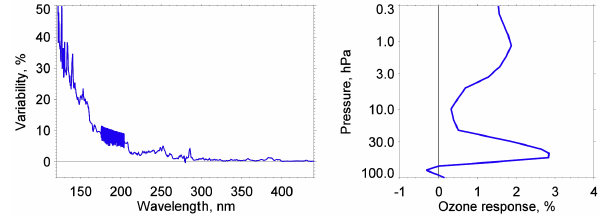
Figure 1. Variability of solar irradiance in the 120–440nm wave- length range calculated by COSI (left) and resulting ozone re- sponse from a composite of observational data from Soukharev and Hood (2006) and Austin et al. (2008)